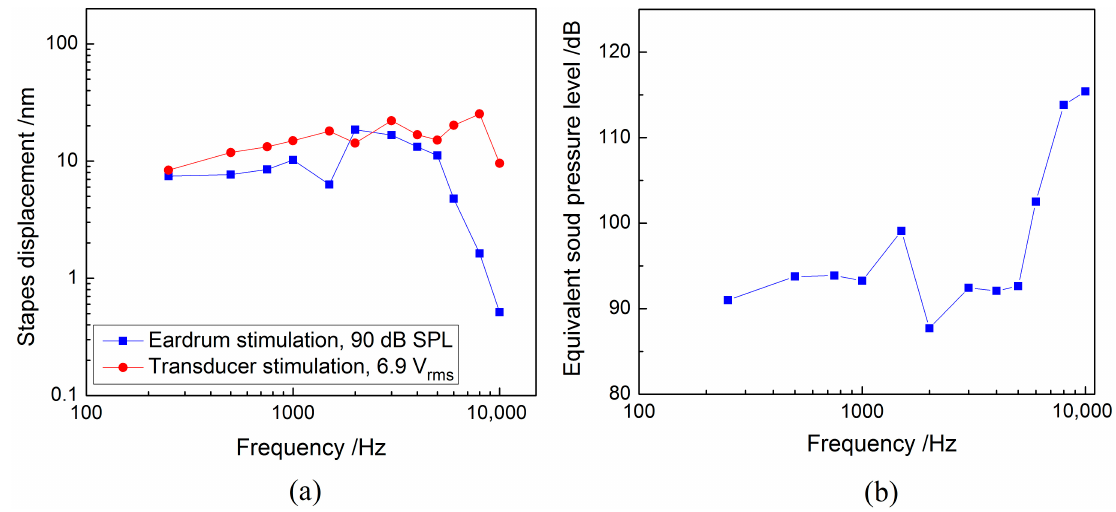
Figure 8. Temporal bone experimental results for the piezoelectric transducer: ( a ) comparison of stapes displacements driven by the piezoelectric transducer and a 90 dB SPL acoustic stimulation at the eardrum; ( b ) equivalent sound pressure levels at the eardrum for the piezoelectric transducer excitation at 6.9 V rms .